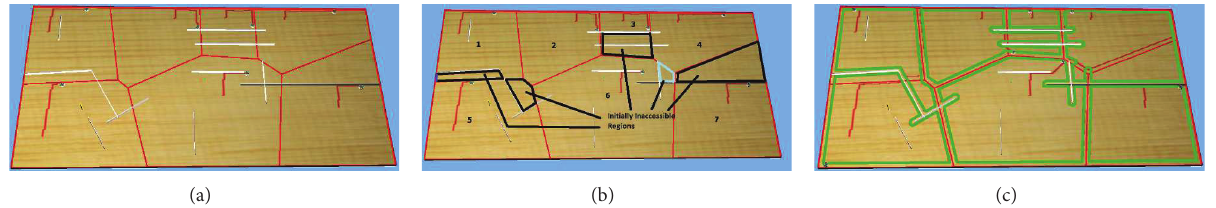
Figure8:SnapshotsfromWebotsshowingrepartitioncoverageby 7 robotsina 3×6 m 2 environmentwithdifferentobstaclefeatures,(a)initial Voronoi partition, (b) robots performing boundary coverage on Voronoi cell, and black/light blue boundaries show inaccessible regions. (c) repartitioned cells and robots completing coverage of entire